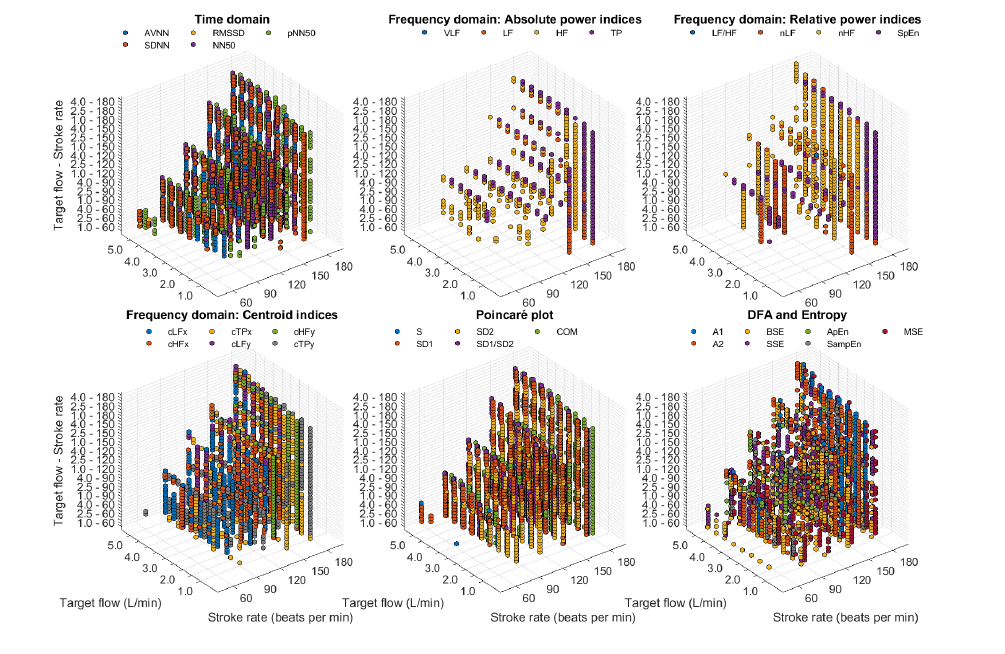
Figure 13. Post-hoc comparisons for the interaction between stroke rate (SR) and target flow (TF) when pulse rate variability indices are measured from the radial phantom. The appearance of a circle indicates a significant difference between the corresponding levels for each of the indices.